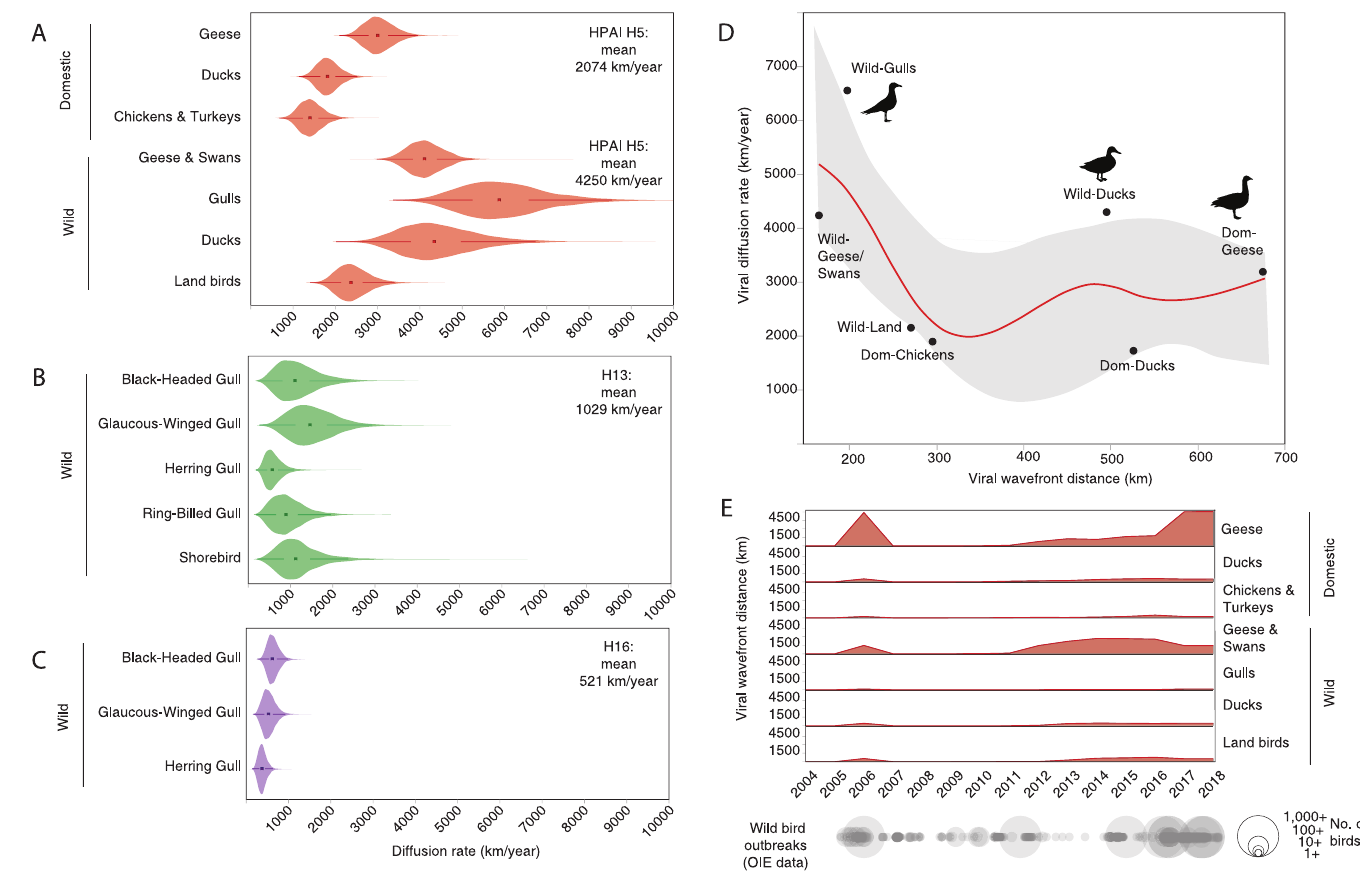
Fig 4. Ecologically divergent hosts contribute to the diffusion and geographic expansion of influenza A virus. A) The diffusion rates of highly pathogenic avian influenza (HPAI) H5 (red), B) H13 (green) and C) H16 (purple). D) Comparison of two dispersal metrics of HPAI H5: viral diffusion (km/year) and viral wavefront distance (km) plotted for each host type (round markers). The red line indicates the negative relationship between viral diffusion and wavefront distance of HPAI H5 based on regression analysis, with grey shading indicating the 95% confidence interval. E) Viral wavefront distances for HPAI H5 fluctuate over time with a large peak during 2005–2006 and a gradual increase from 2010 onwards. Dispersal rates (km/year) and wavefront distance (km) were estimated using a joint continuous geographic and discrete host diffusion model. Wild bird outbreak data are courtesy of the World Organisation for Animal Health. Available from: